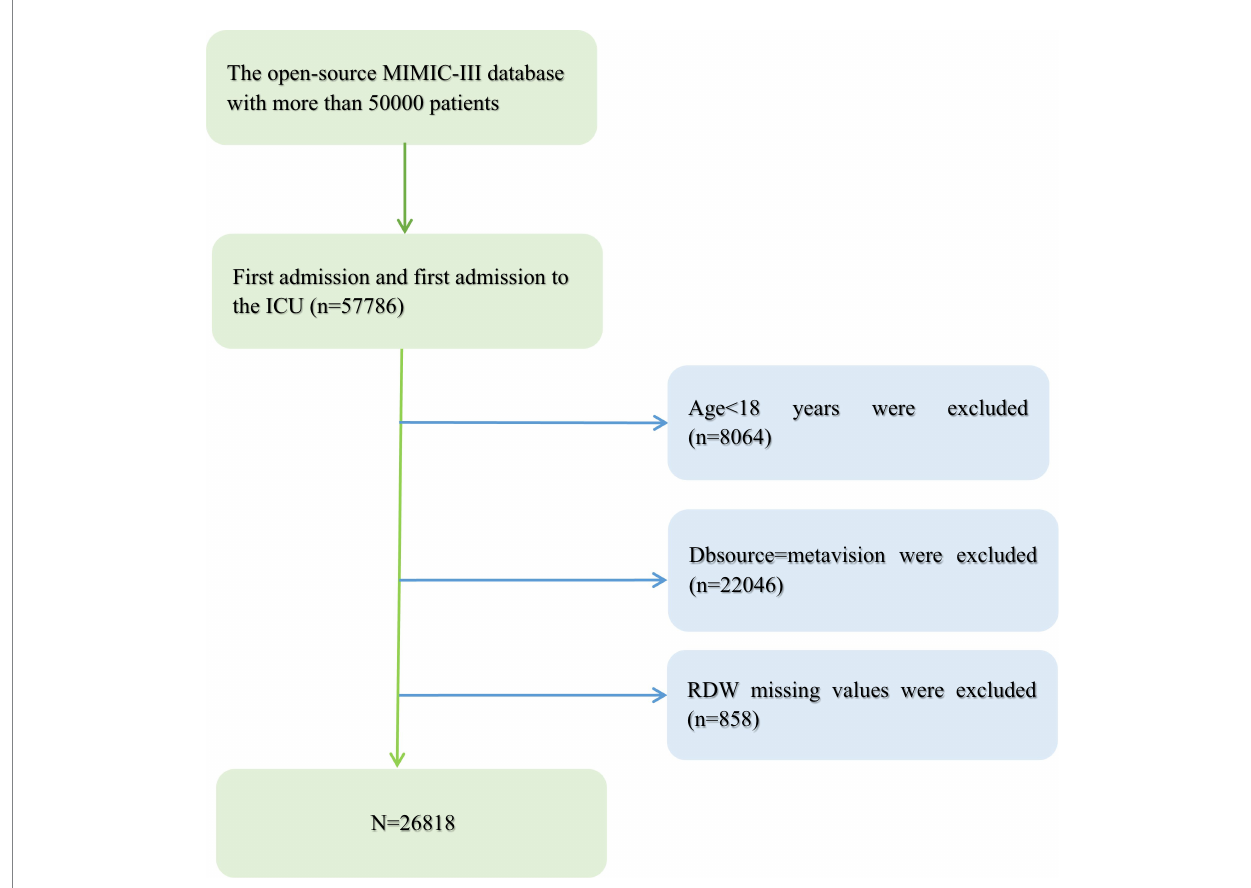
FIGURE 1 Flowchart of patient